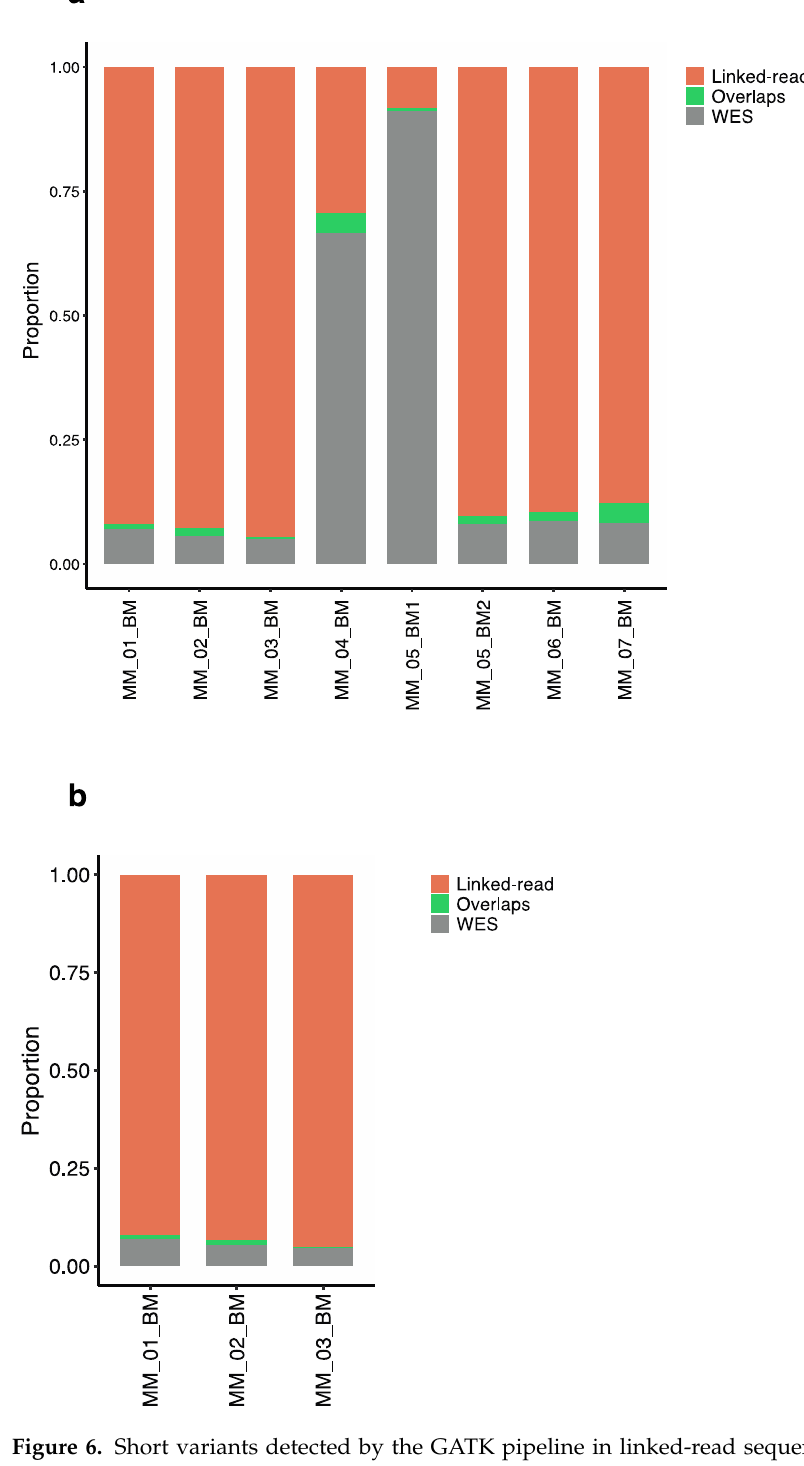
Figure 6. Short variants detected by the GATK pipeline in linked-read sequence and WES data. ( a ) The bar plot depicts the number of short variants detected by linked-read and WES methods in 8 tumor samples. Except for two samples, linked-read sequencing detected a higher proportion of short variants. ( b ) The short variants detected by GATK in 3 paired samples.